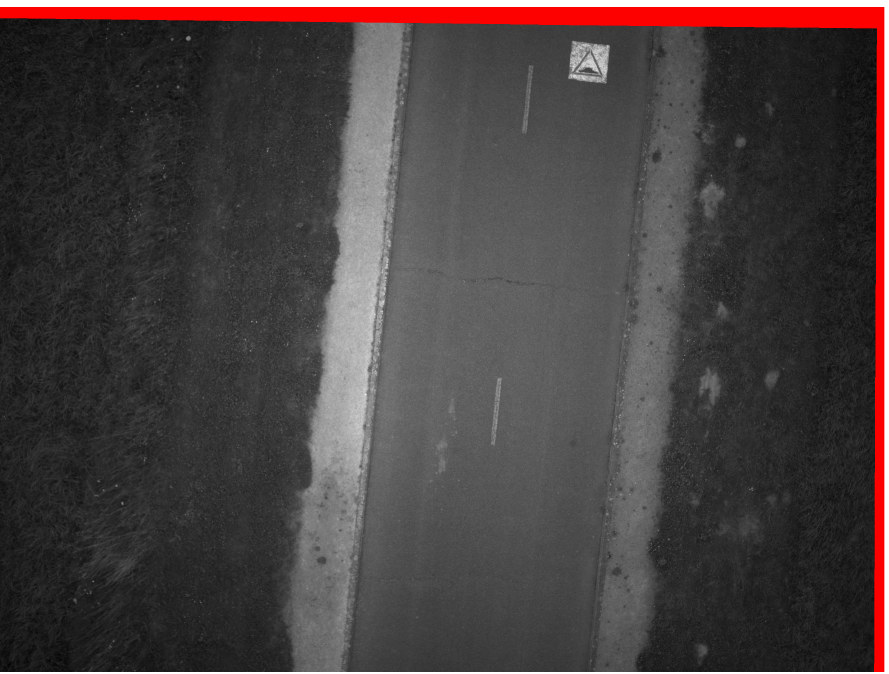
Figure 19. The stacked image. The red part is the non-common part between the first image and the 10th